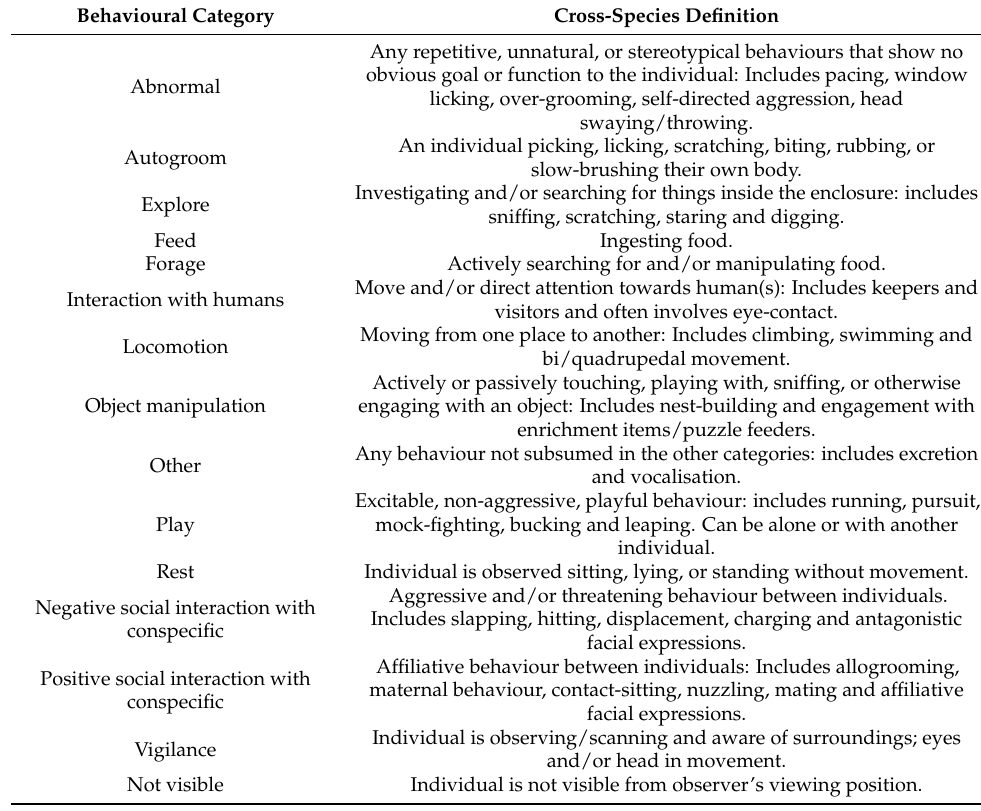
Table 2. Descriptions of behaviours used for